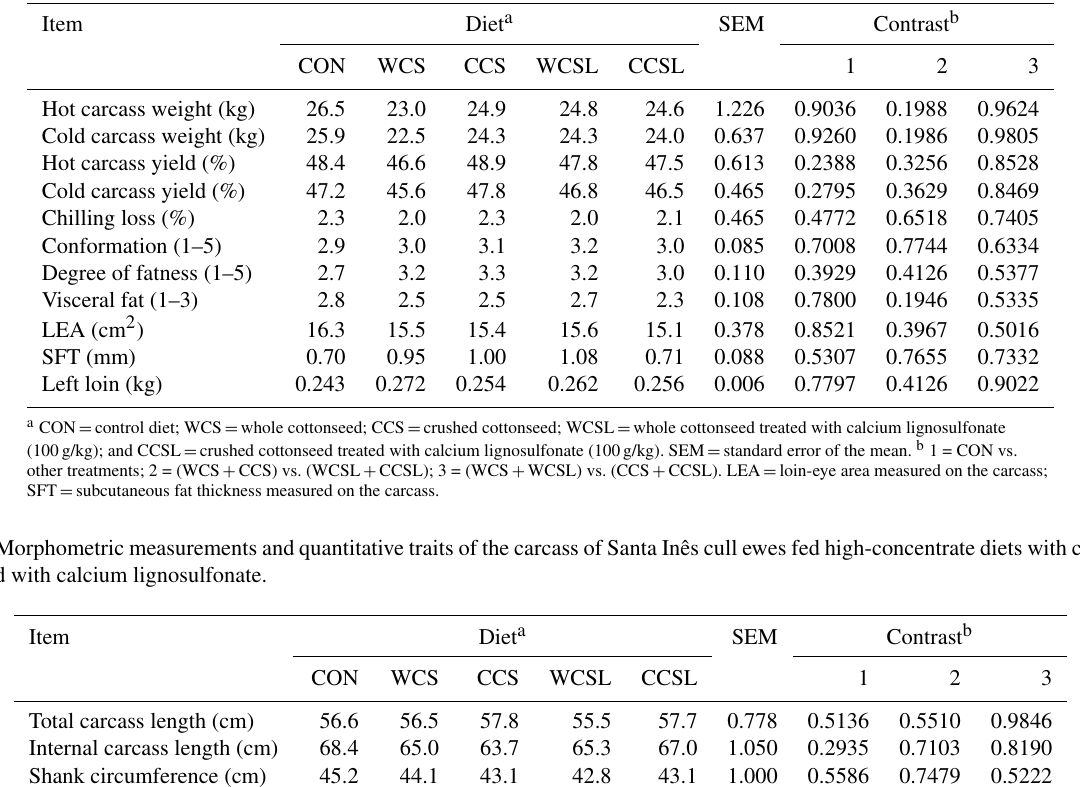
Table 3. Performance and qualitative traits of the carcass of Santa Inês cull ewes fed high-concentrate diets with cottonseed associated with calcium lignosulfonate.